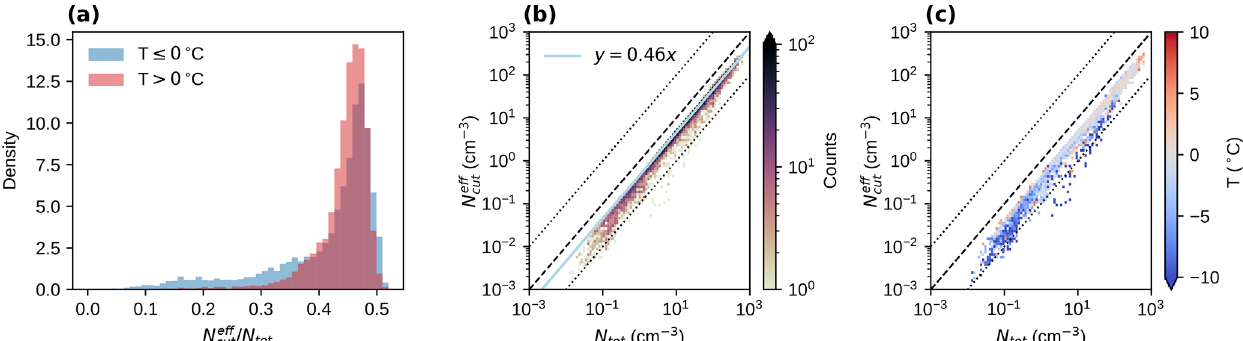
Figure 3. Cloud particle number concentrations with and without taking the GCVI sampling efficiency and cut size into account. Comparison of fog monitor total integrated cloud particle number concentration after correcting for the GCVI transmission efficiency (Shingler et al., 2020) and cut size ( N eff cut ) divided by the total integrated cloud particle number concentration without correction ( N tot ). Panel (a) shows histograms of the ratio for temperatures > 0 ◦ C (red) and temperatures ≤ 0 ◦ C (blue). Panel (b) shows a density scatter plot of N tot vs. N eff cut for all data points (both histograms), together with an ODR best fit slope, and (c) shows the same as (b) but colour coded by the average temperature instead of the data point density. In (b) and (c) , the dashed black line represents the 1 : 1 line, and the dotted lines represent 10 : 1 and 1 : 10